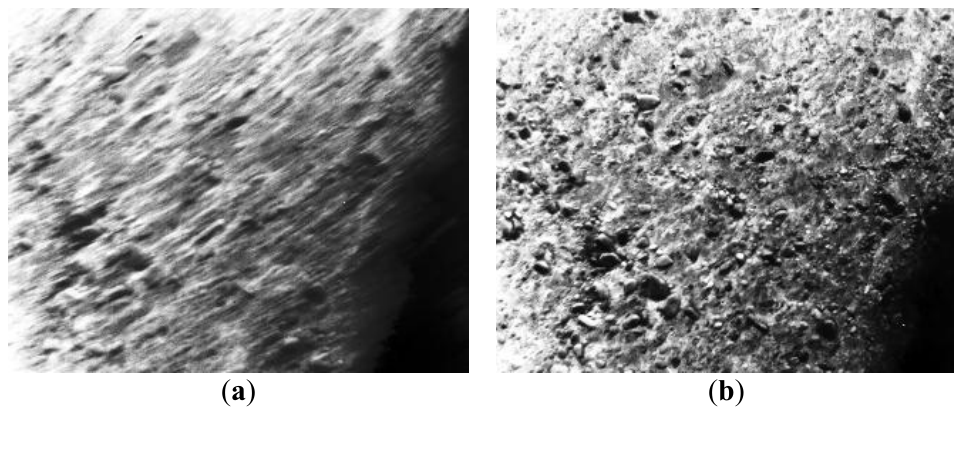
Figure 3. Comparison of two consecutive TIR frames; ( a ) blurry image with blur index of 0.32, and ( b ) sharp image with blur index of